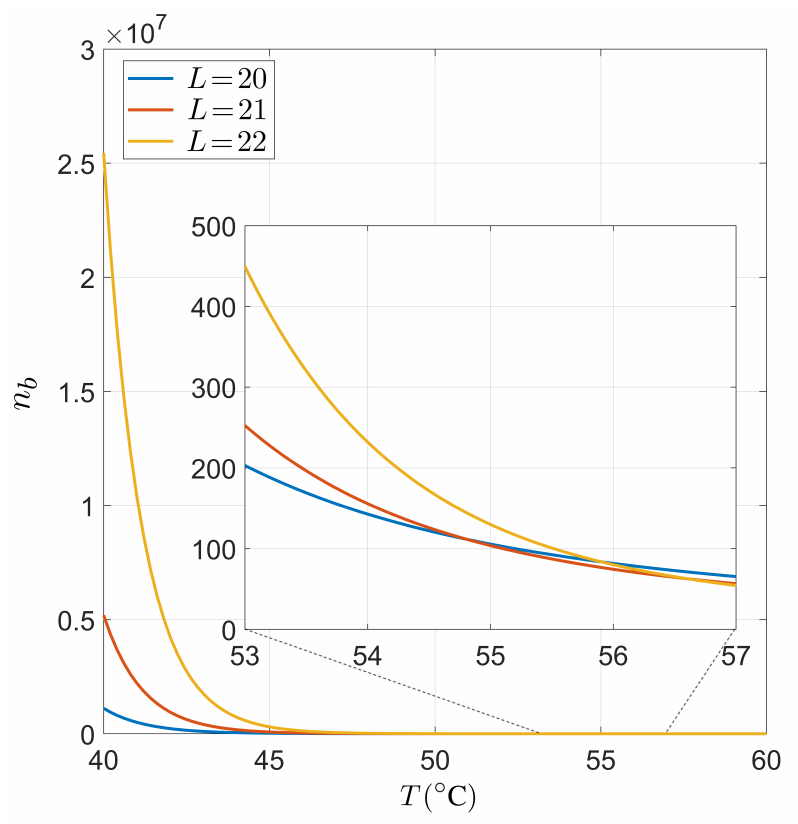
Figure A2. Dependence on the temperature T of the typical number of primers bounded per genome. We have considered fixed values for c p = 400 nM, c g = 0.4 fM, L 0 = 6 × 10 9 , whereas we have considered L = 20, L = 21 and L = 22 as typical primer lengths. The drop of n b around the working temperature justifies the use of the approach used in the main